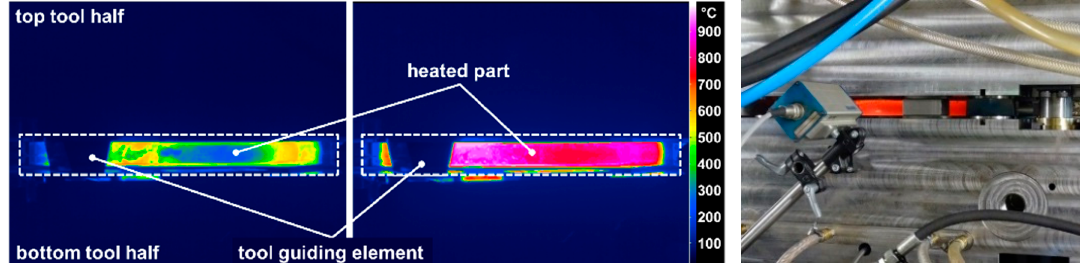
Figure 6. View of thermal camera after 30 s (l) and 50 s heating time (m), real heated component (r).